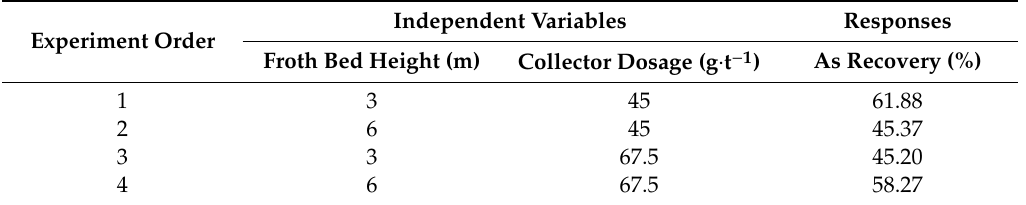
Table 5. Experiment conditions and responses of flotation tests.